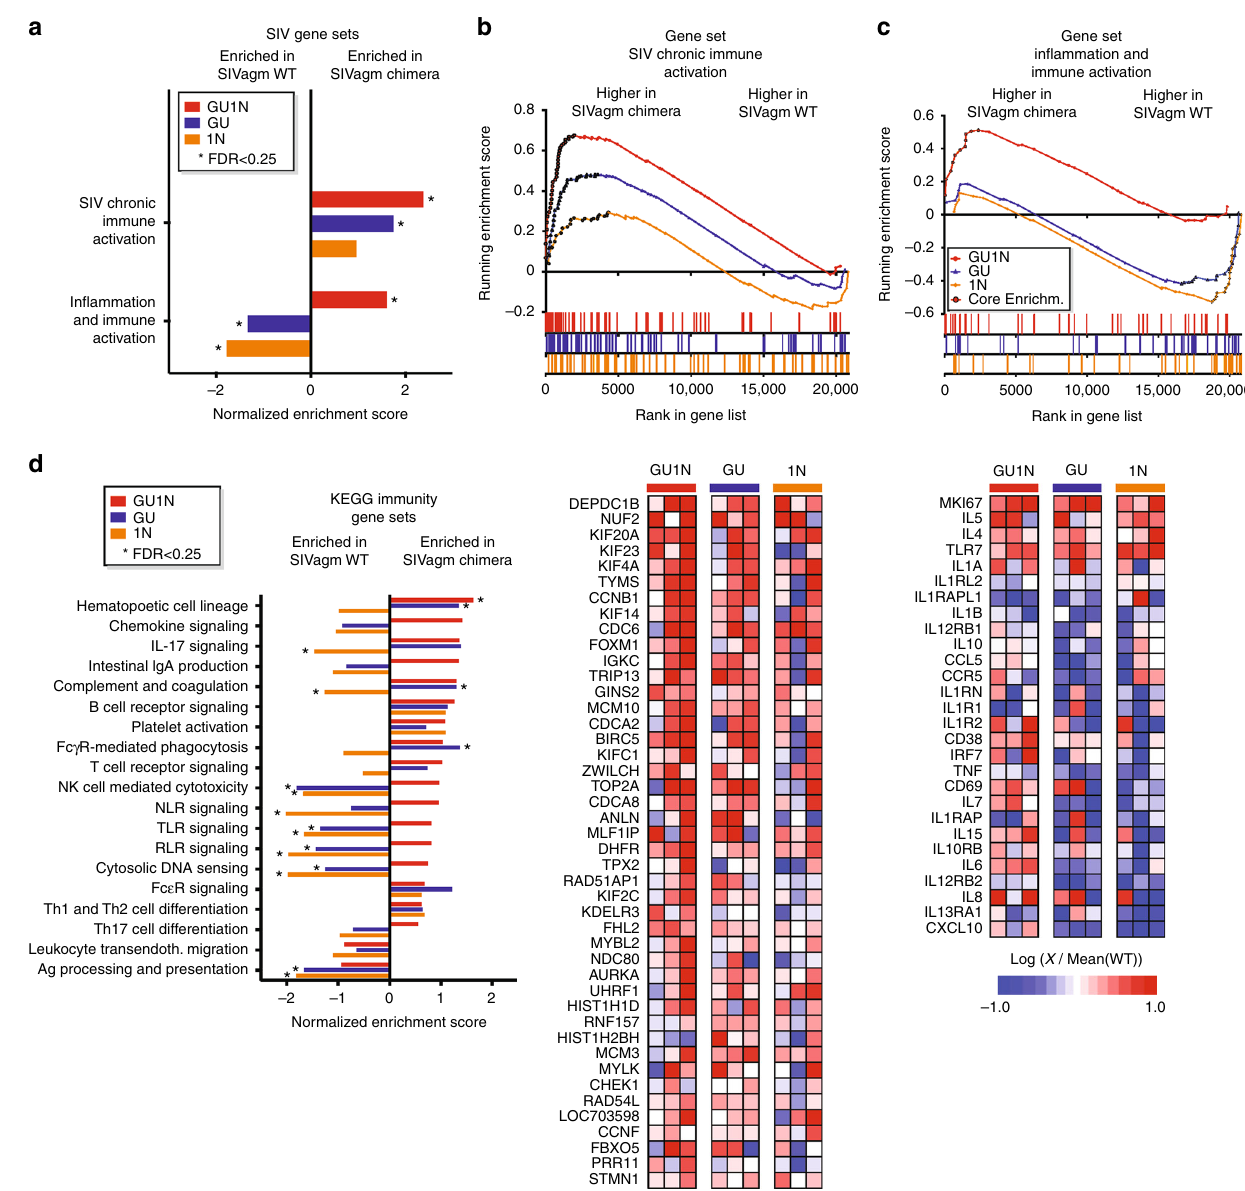
Fig. 6 Effect of WT and chimeric SIVagm infection on cellular gene expression in AGMs. a , d Enrichment scores of gene sets generated from in vivo SIV infection transcriptional pro fi ling experiments ( a ) or immune-related genes from the KEGG database d . GSEA analysis was used to contrast transcriptome- wide gene expression pro fi les from day 170 between the WT SIVagm infected samples and each of the chimeric infections. Gene sets with an FDR of <0.25 were considered signi fi cant and are indicated by an asterisk. b , c Enrichment plot (upper) and leading-edge heat map (lower) of GSEA analysis of WT vs. GU1N, WT vs. GU, and WT vs. 1N datasets for enrichment of the “ SIV chronic immune activation ” ( b ) and “ in fl ammation and immune activation ” ( c ) gene sets. The plot in the upper panels depicts the running enrichment score indicated by the line adjoining data points. Each data point represents an individual gene in the gene set. Genes contributing the most to the enrichment score (Core genes or leading edge genes) are indicated by bolded symbols. Each bar in the stick plot at bottom indicates the position of an individual gene from the gene set within the entire dataset (indicated on X axis). The lower panel depicts a heat map of “ leading edge ” or “ Core ” genes from the enrichment plots. The genes in the leading edge of all three GSEA contrasts (WT vs. GU1N, WT vs. GU, and WT vs. 1N) were pooled, and normalized to the mean of the WT genes. Genes are ranked according to their position in the WT vs. GU1N analysis. Color scale shown at